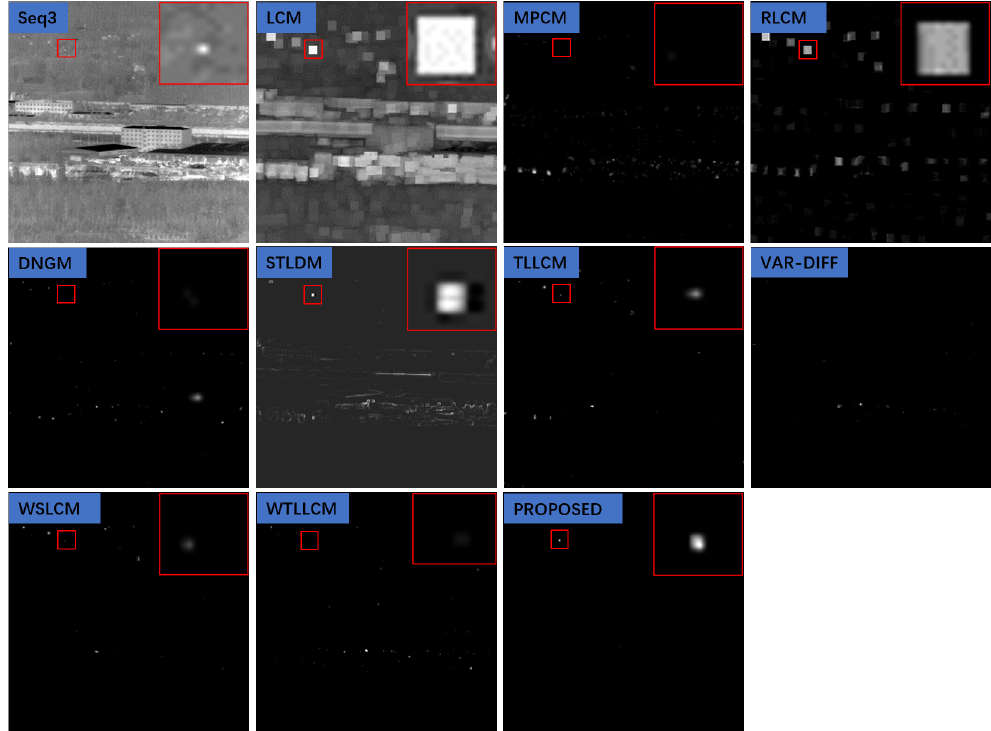
Figure 19. Detection results of one frame in data3. The first sub-image is the original image, and the rest are the detection results of each algorithm.